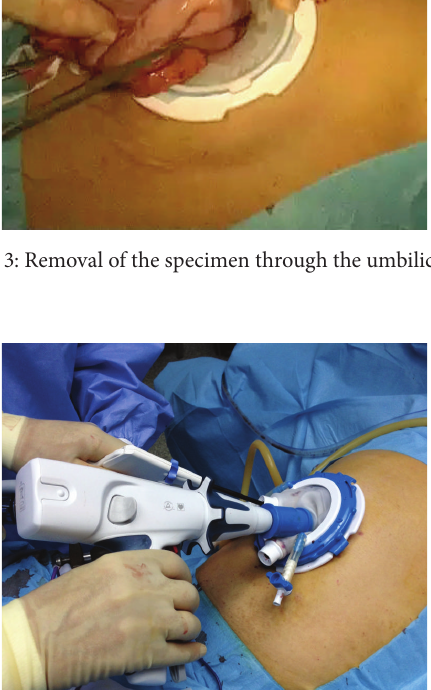
Figure 2: Transection of the esophagus using a linear stapler. forceps were introduced. The greater omentum was divided using Ligasure 5 mm (Covidien, USA). After the division and ligation of the left gastroepiploic vessels at the root, dissection around the lymph nodes was continued toward the pylorus.